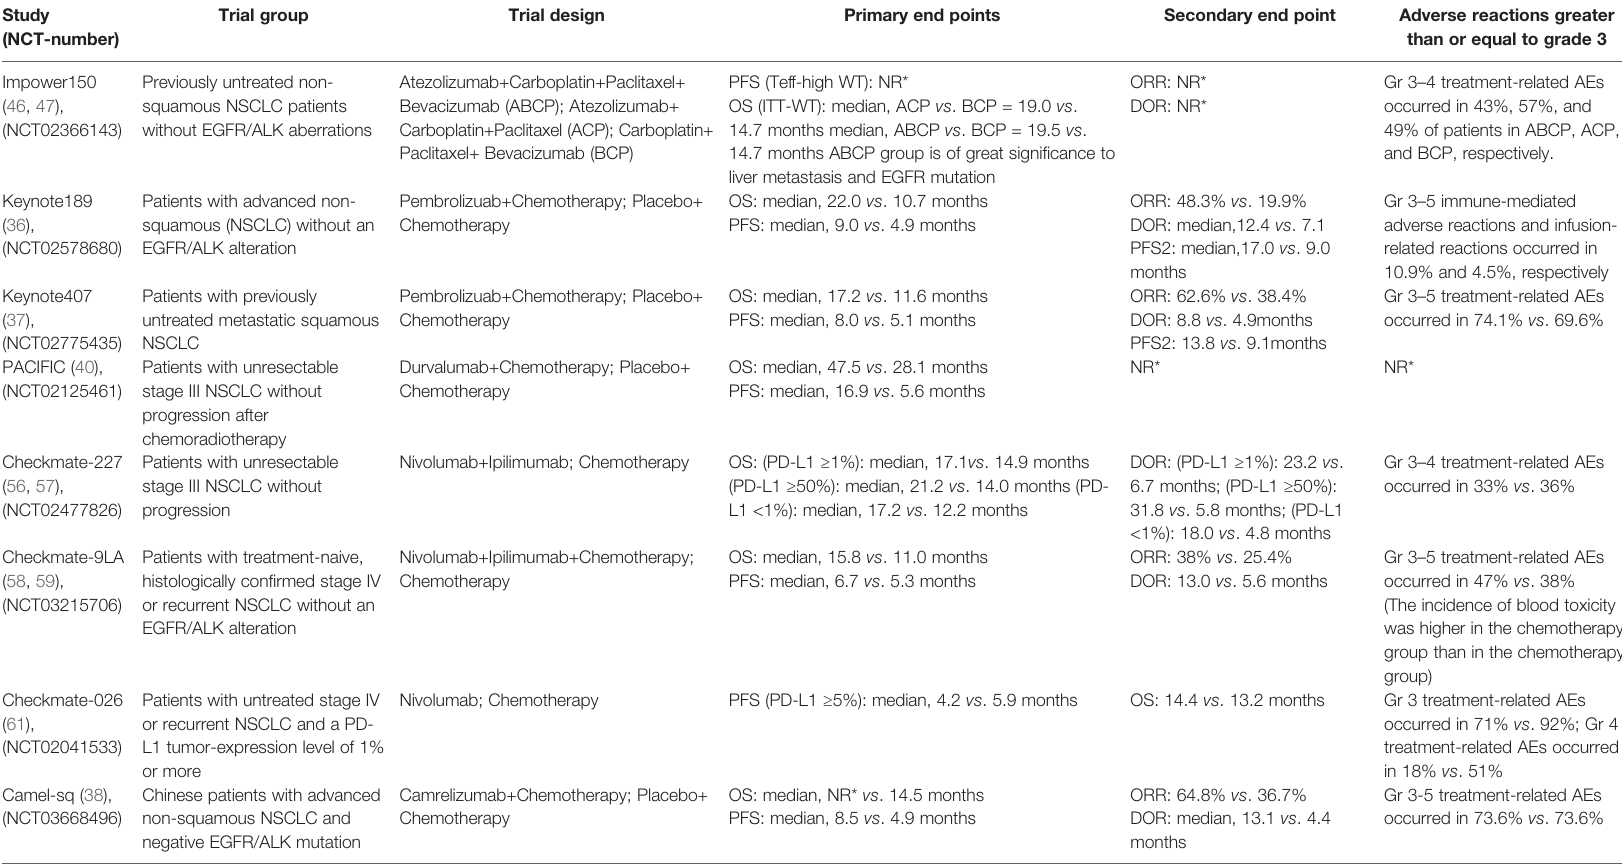
TABLE 1 | Data on the results of trials related to non-small cell lung